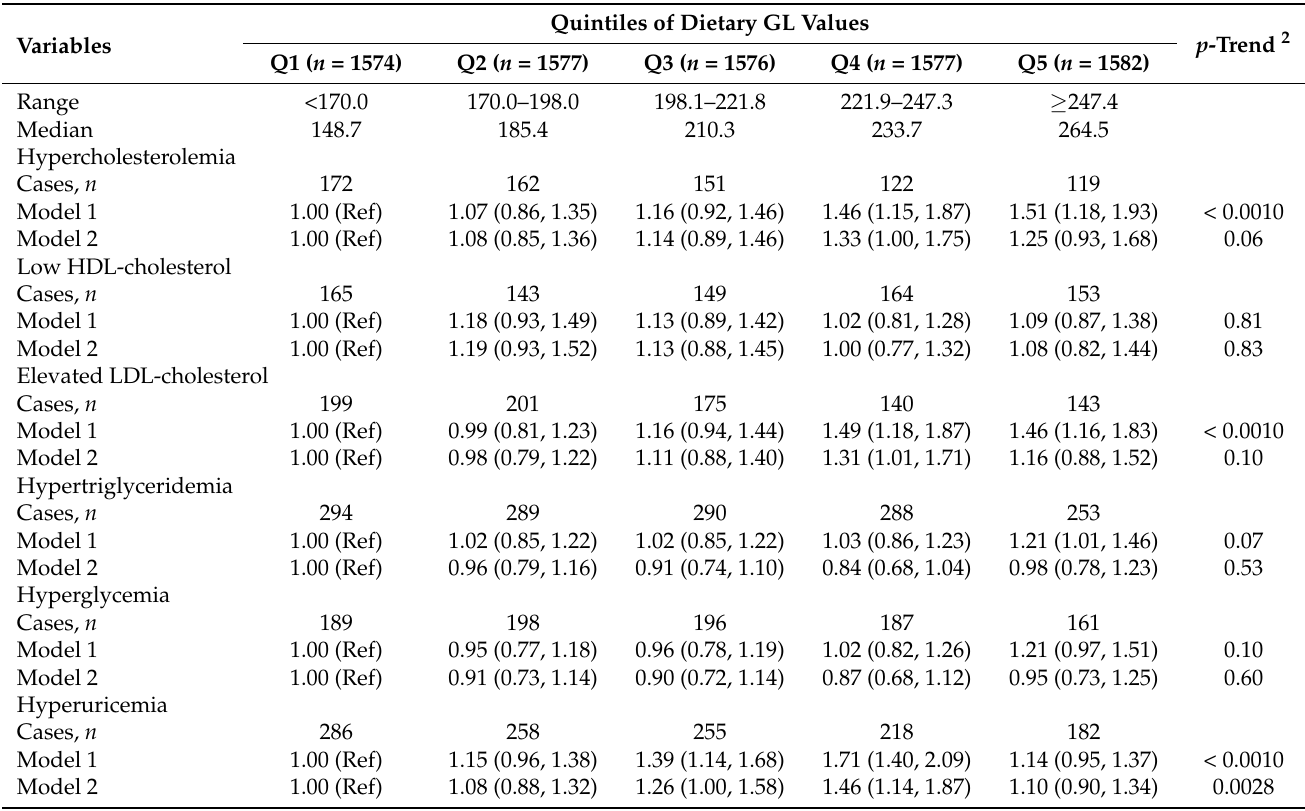
Table 3. The associations between quintiles of dietary GL values and cardiometabolic risk factors of 7886 Chinese adults who participated in the China Health and Nutrition Survey 2009 ( N = 7886) 1